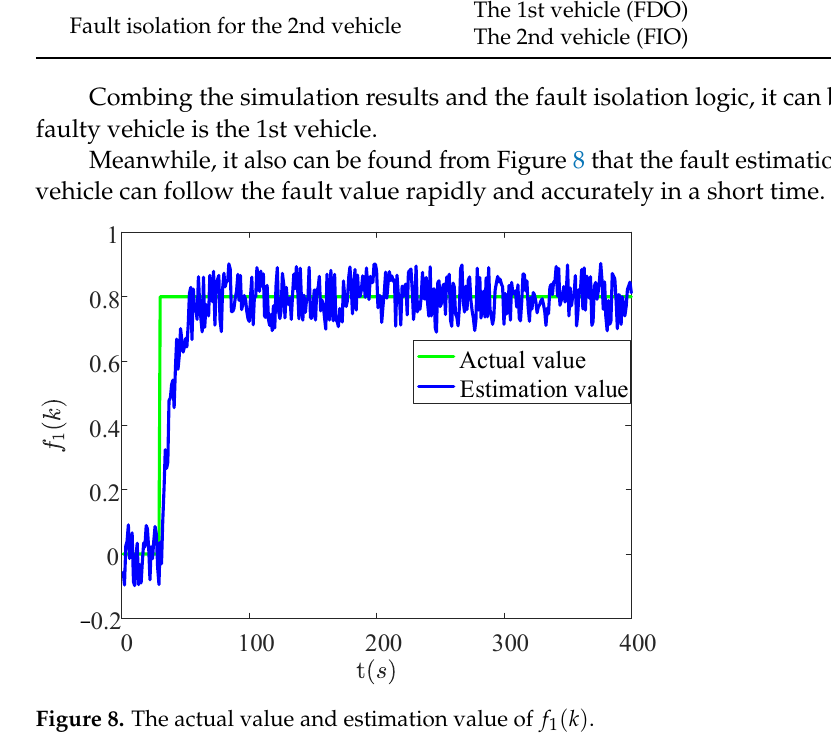
Figure 9. Displacements of four vehicles with the use of fault-tolerant control scheme.